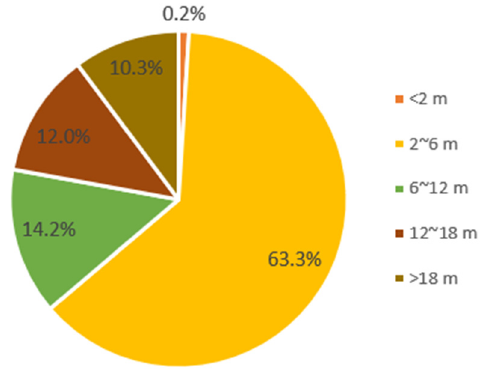
Figure 7. Corresponding areas of different groundwater depths.